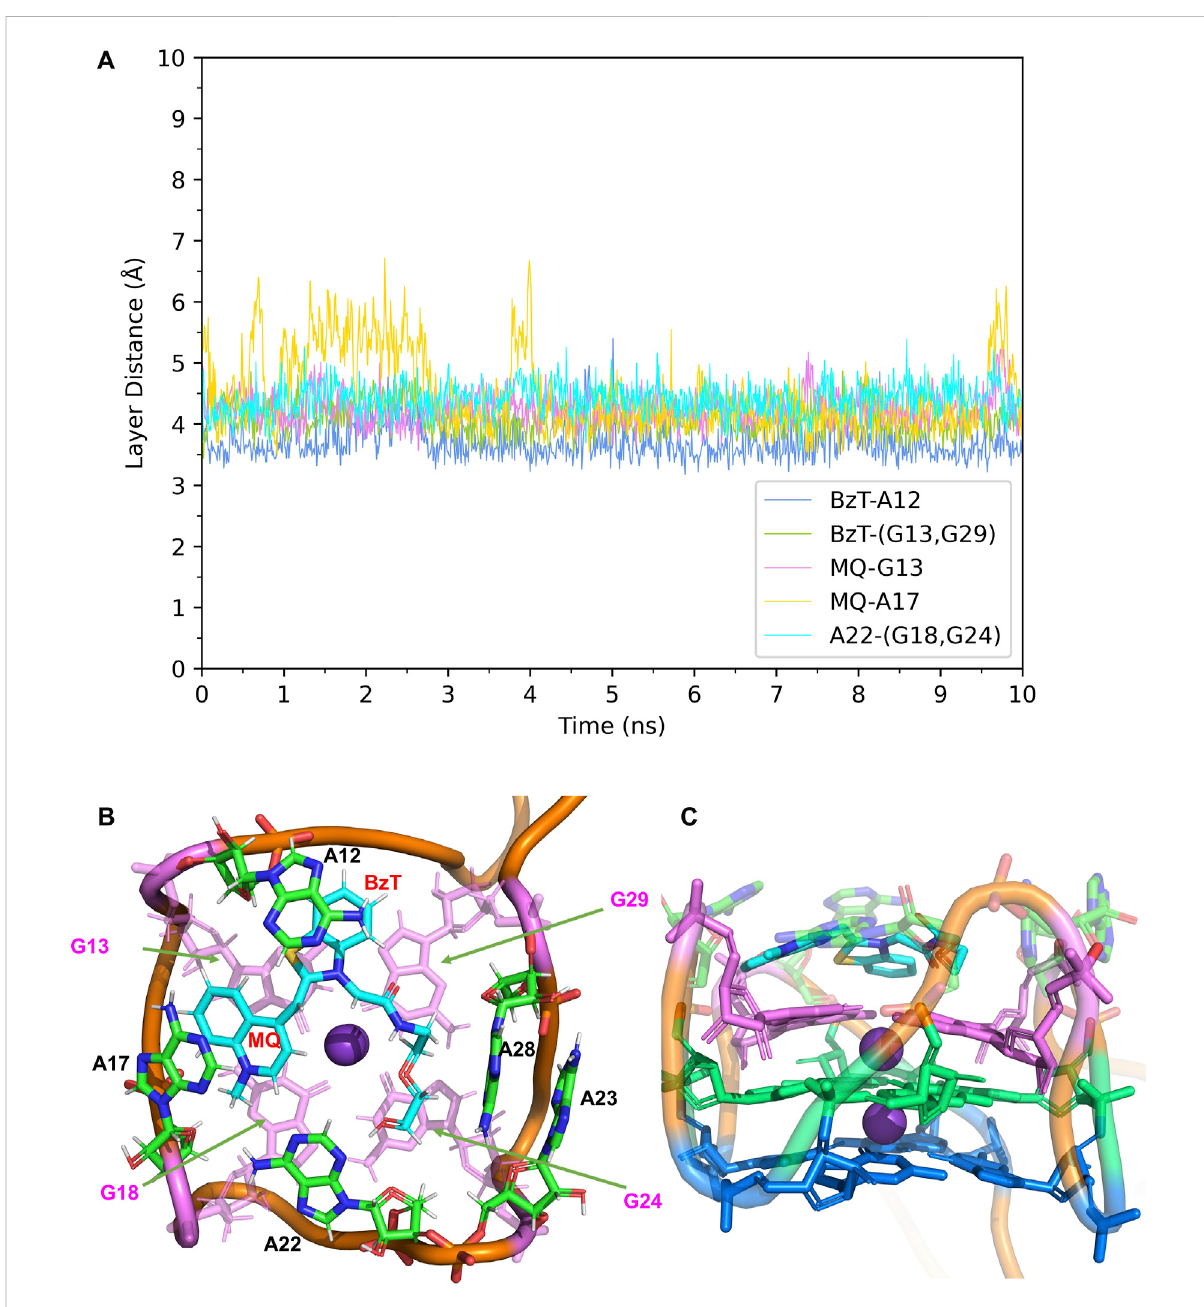
FIGURE 4 Structural analysis of MD simulation on wild-type Mango-II with TO1-Biotin. (A) : the trajectories of important structural parameters in the MD process. (B) :thetopviewofequilibriumstructurefromtheMDprocess(5 nssnapshot),withtheligandshownincyanandT3guaninesshowninpink. (C) : the side